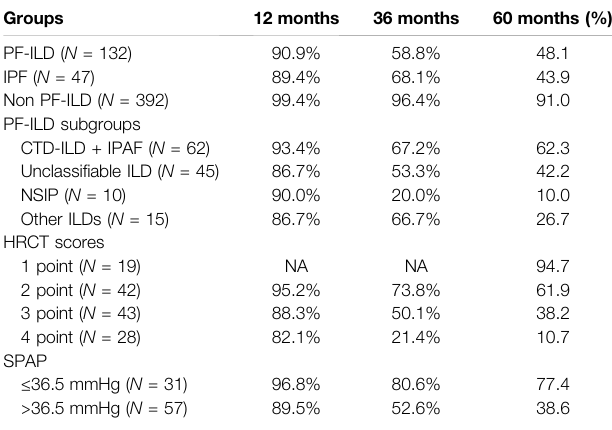
TABLE 3 | Accumulate survival rates.